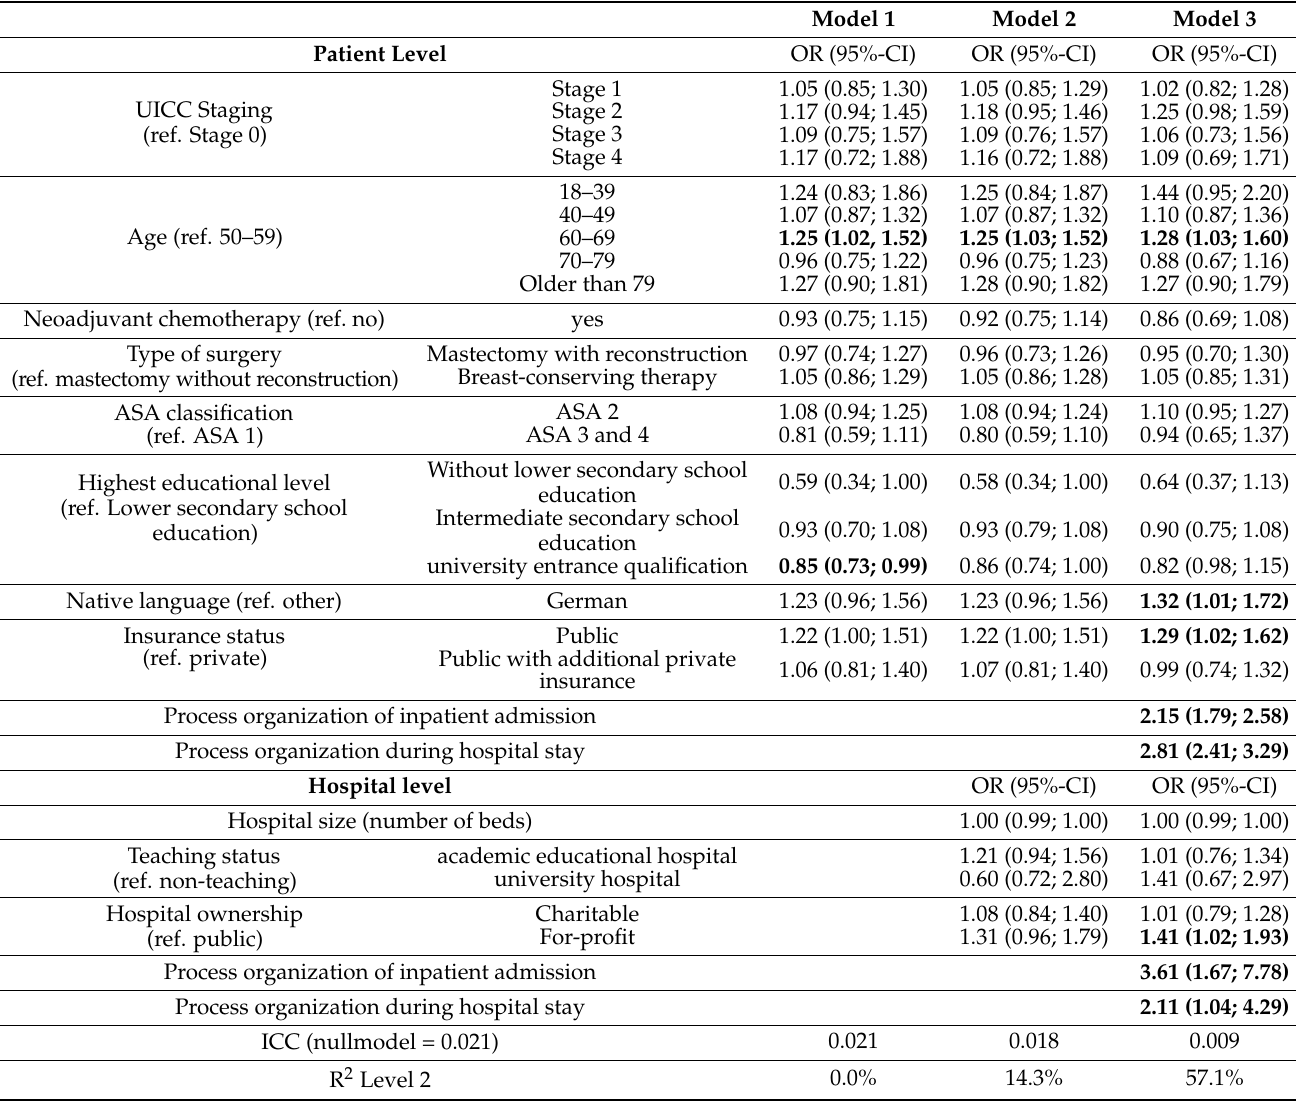
Table 4. Logistic hierarchical regression models with perceived support from nurses as the dependent variable; odds ratios (OR) and 95% confidence interval